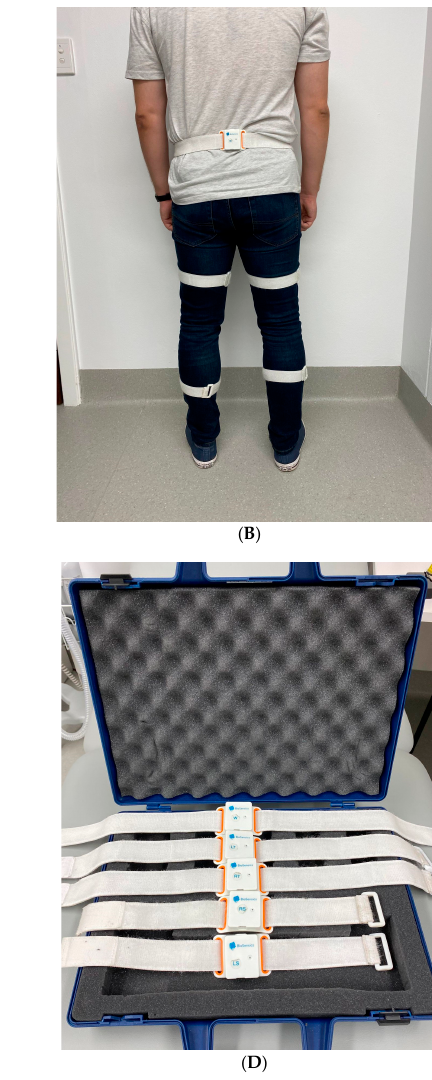
Figure 2. Reflective passive clusters on shoes and representation in the Motive program. ( Left ): A reflective marker cluster was taped to the back of each plimsoll shoe for testing. ( Right ): Marker representation in Motive, with the blue, red and green lines indicating the X, Y, Z axes of the clusters, respectively.